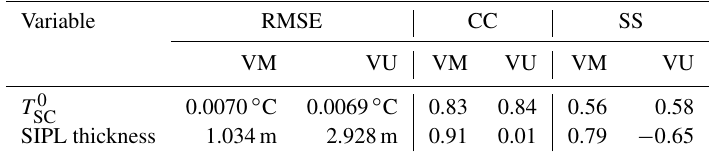
Table 2. List of calculated skill metrics for the results of VM and VU standard model